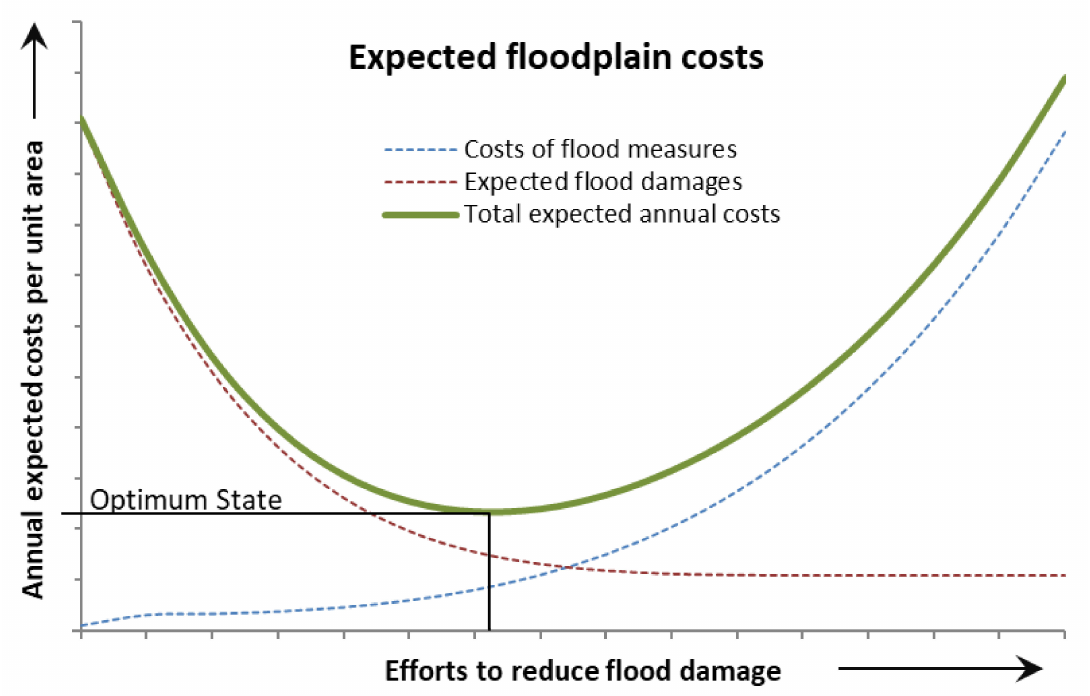
Figure 3. Graphs representing the increasing costs of flood measures and reduction in flood damages, along with the variation in total costs within the floodplain, which is minimum at the optimum state